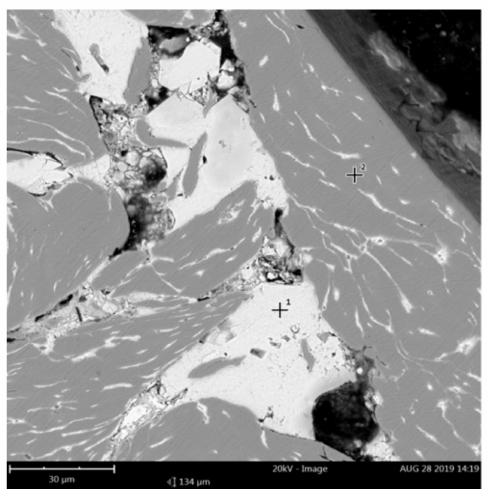
Figure 13. Microanalysis in the light and gray phase area—analysis site marked with a cross.